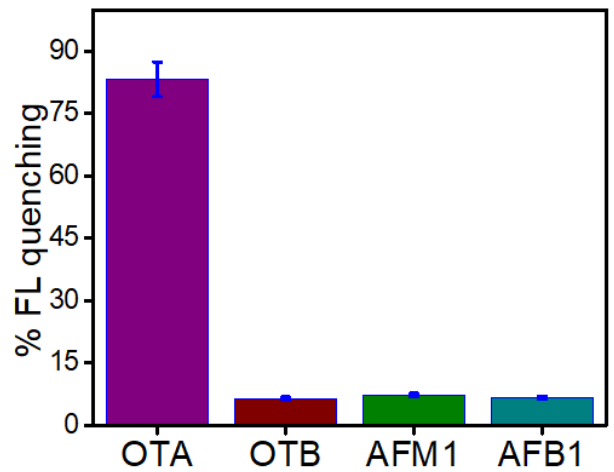
Figure 10. Response of developed aptasensor for OTA and other interfering species at a concentration of 200 ng/L in PBS (pH 7) under optimized conditions. ZnSe-nanostructure-based fluorescent aptasensor was validated by detecting OTA in rice extracts. Three varying concentrations of OTA, i.e., 5, 50 and 100 ng/L were spiked to rice samples purchased from a local market. The recovery of spiked OTA was deter- mined using the developed aptasensor. As shown in Table 2, the recovery and repro- ducibility were acceptable in all cases. The FL quenching recovery % response of OTA in buffer was in strong agreement with OTA spiked samples. The relative standard devia- tion (R.S.D %) of these recovery experiments were 0.56%, 0.22% and 0.218% for n = 3, which demonstrates good stability, reproducibility and practical applicability of the de- veloped aptasensor. Comparison of some recent nanostructure-based fluorescent sensors for OTA detection is presented in Supplementary Table S2. Table 2. Determination of OTA spiked in rice extract (n = 3). Sr. No.